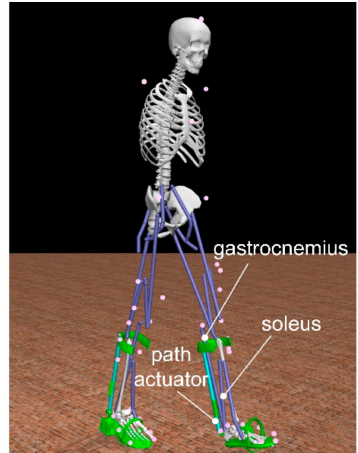
Figure 10. A Human musculoskeletal model with the passive AFE worn on both legs in the environment in OpenSim.